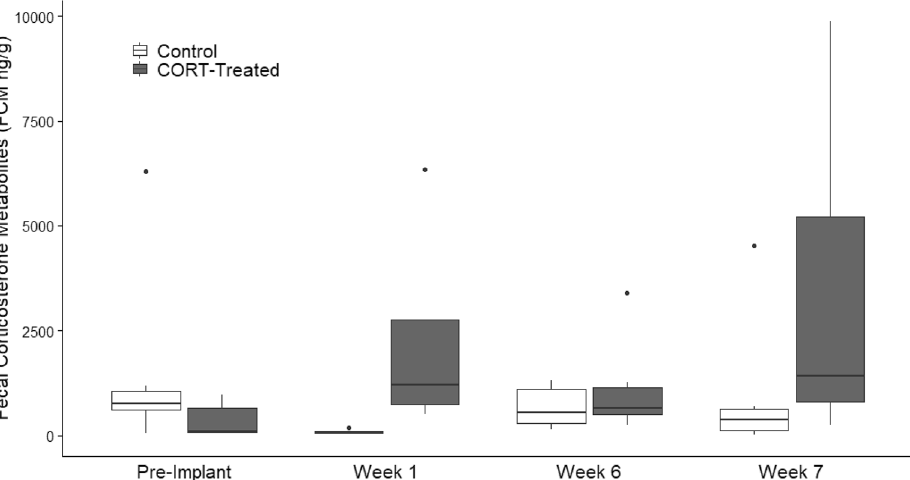
Figure 2. Fecal corticosterone metabolites of banner-tailed kangaroo rats that we implanted subcutaneously with either blank silastic rods (controls) or rods filled with crystalline corticosterone at a dose of 160 mg/kg BW. We captured kangaroo rats during the first and several weeks after implantation to collect fecal samples for CORT